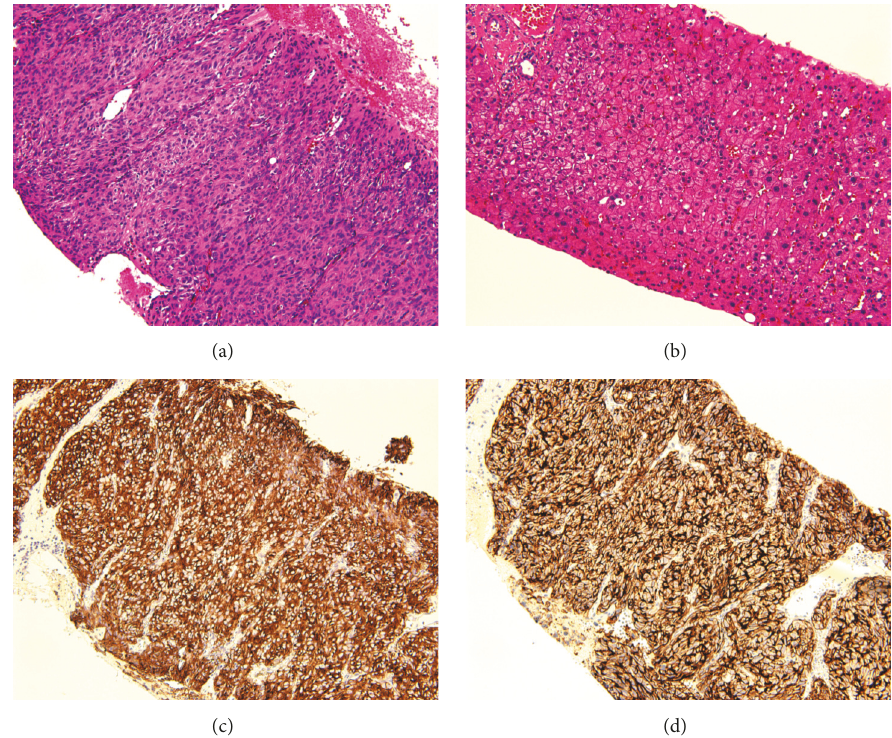
Figure 1: 20x micrographs, (a–d). Spindle cell neoplasm (a) is more cellular when compared to surrounding liver tissue (b). The tumor cells of spindle cell neoplasm (a) appear uniform, with monomorphic nuclei and eosinophilic cytoplasm. Tumor cells stain strongly positive for CD117 (c) and DOG1